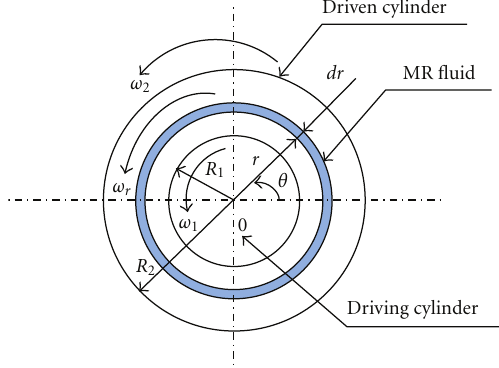
Figure 3: Circular flow of MR fluid between two cylinders.